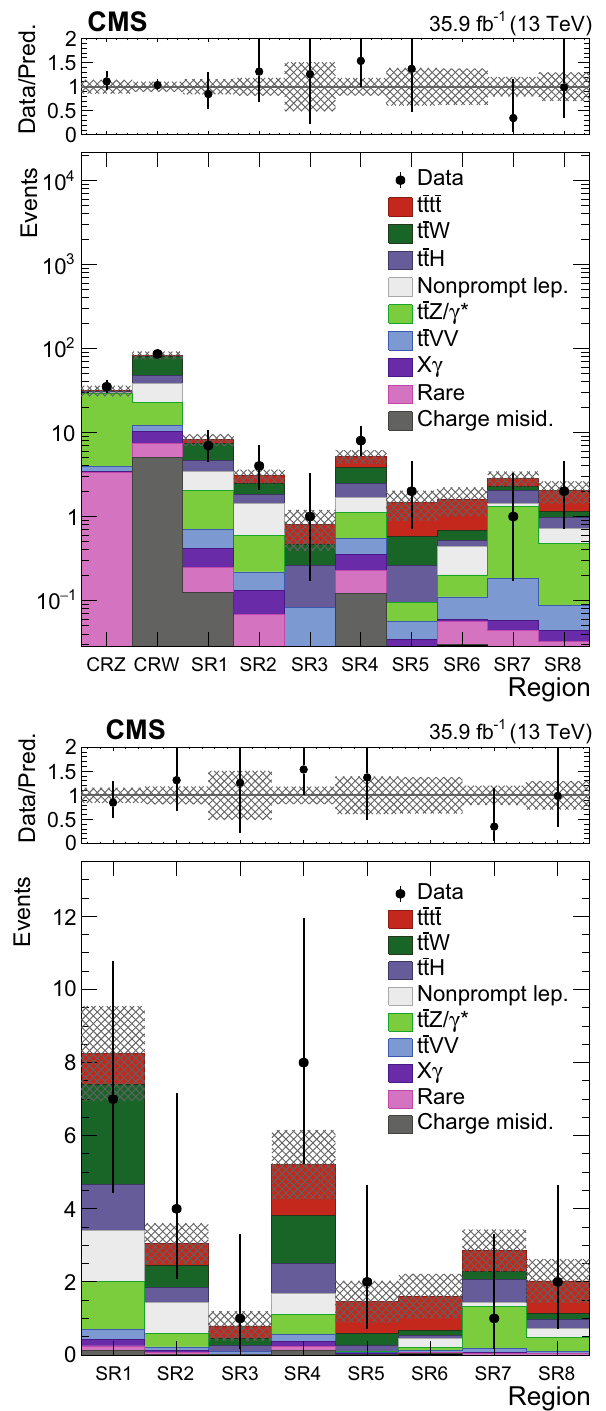
Fig. 4 Observed yields in the control and signal regions (upper, in log scale), and signal regions only (lower, in linear scale), compared to the post-fit predictions for signal and background processes. The hatched areas represent the total uncertainties in the signal and background pre- dictions. The upper panels show the ratios of the observed event yield and the total prediction of signal and background. Bins without a data point have no observed events